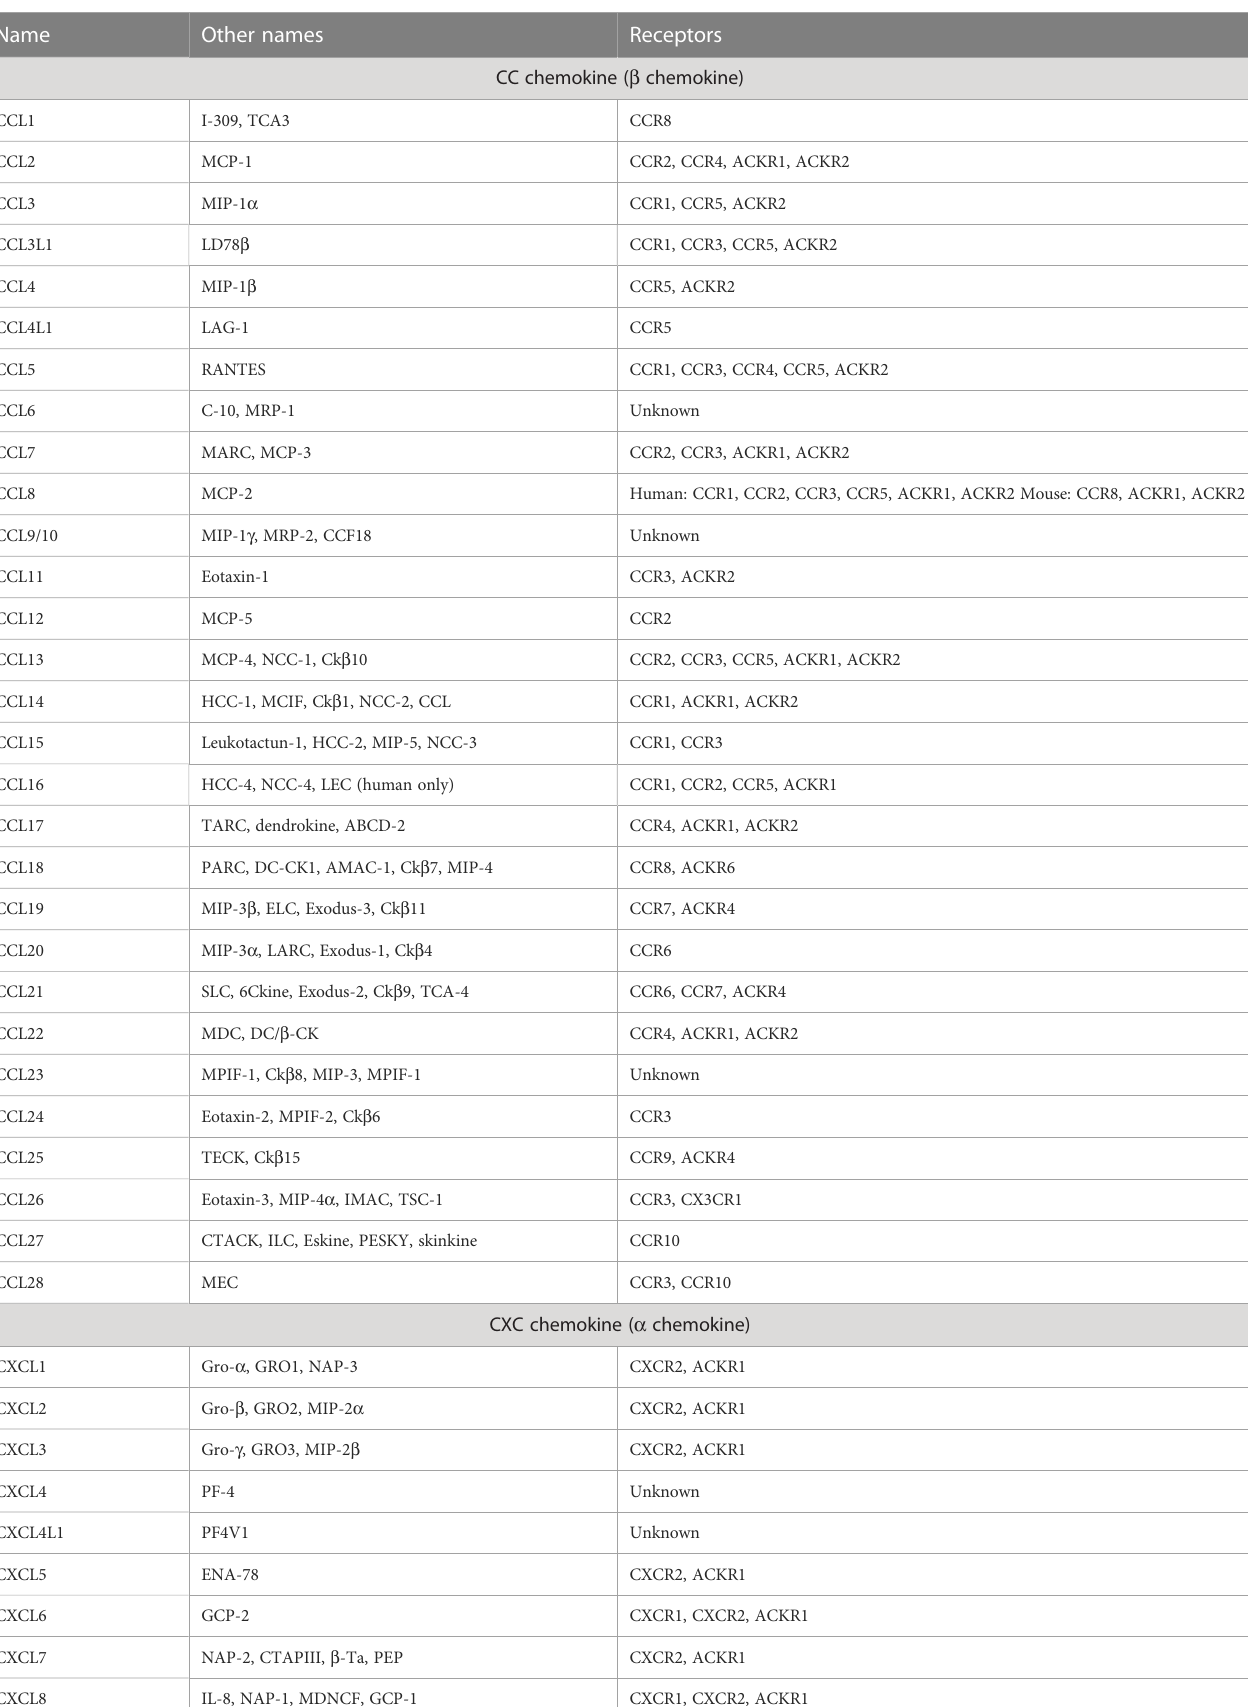
TABLE 1 The chemokines and chemokine